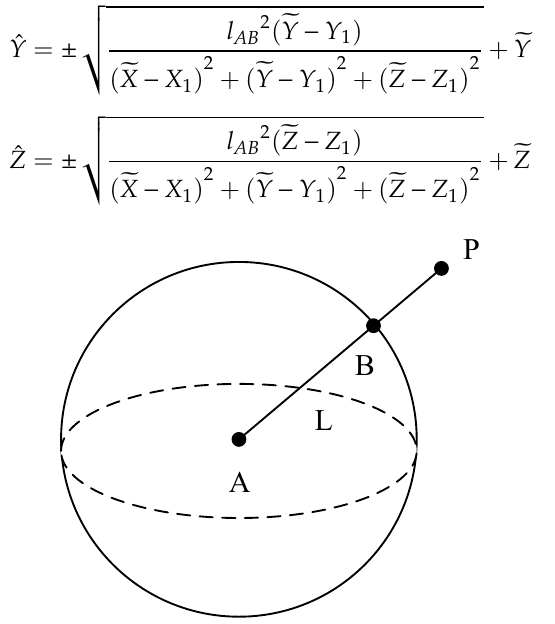
Figure 3. Schematic diagram of the position of error joint B.